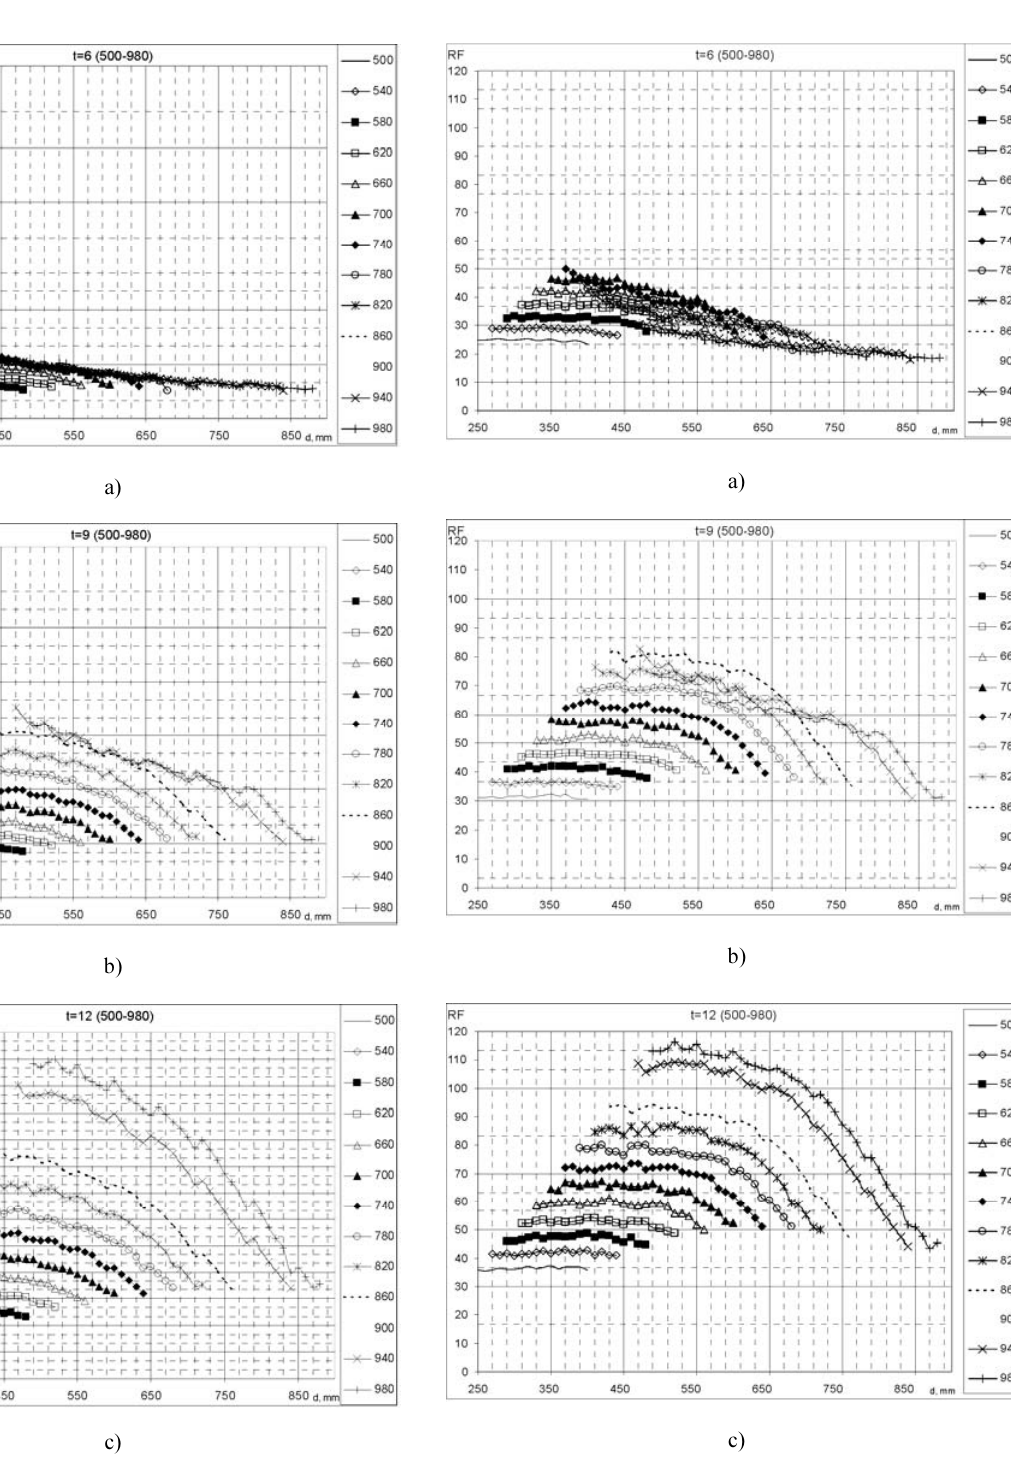
Fig. 6. Dependence of RF versus d : a) for w t = 6 mm; b) for w t = 9 mm; c) for w t = 12 mm − When the web depth is not very big (500 700 mm), the perforation diameter has a negligible influence on the rational factor. The bigger the web depth, the higher the influence of perforation diameter on the rational factor, i. e. the bigger the perforation diameter, the smaller the rational factor